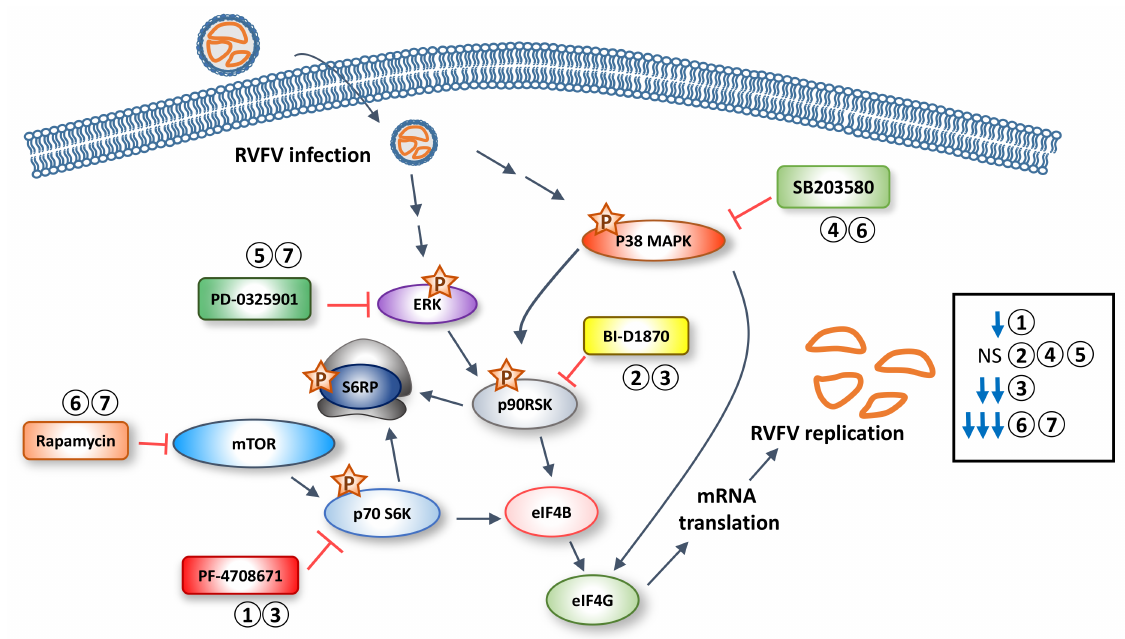
Figure 8. Schematic depicting the influence of kinase inhibitors on RVFV replication. RVFV infection leads to induction of ERK and p38 MAPK phosphorylation, followed by phosphorylation of p70 S6K and p90RSK. p70 S6K phosphorylation can be induced via mTOR activity, whereas p90RSK is phosphorylated by ERK and/or indirectly through p38 MAPK. Both p70 S6K and p90RSK can phosphorylate S6 ribosomal protein (S6RP) and eIF4B, leading to increased mRNA translation. The numbers above the kinase inhibitors refer to the manuscript figure number where the inhibition data are presented. The influence of the 5 different kinase inhibitors on RVFV replication tested alone or in combination is summarized on the right side of the diagram. NS = no significant change in RVFV